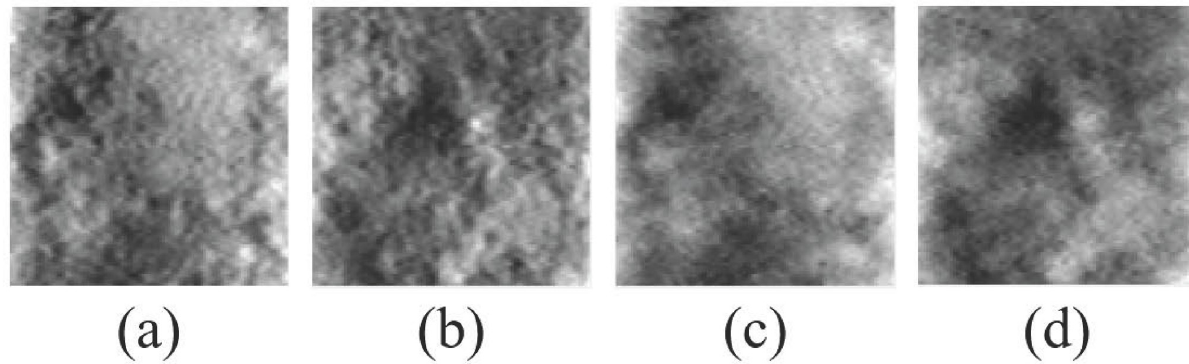
Fig 5. Examples of reconstructed simulated breast phantom without spherical signal. (a) and (b) are reconstructed images using projection data in step-and-shoot mode, and (c) and (d) are corresponding images using projection data in continuous mode. The display window is set by [min. max.] mm − 1 to visualize the background structures more